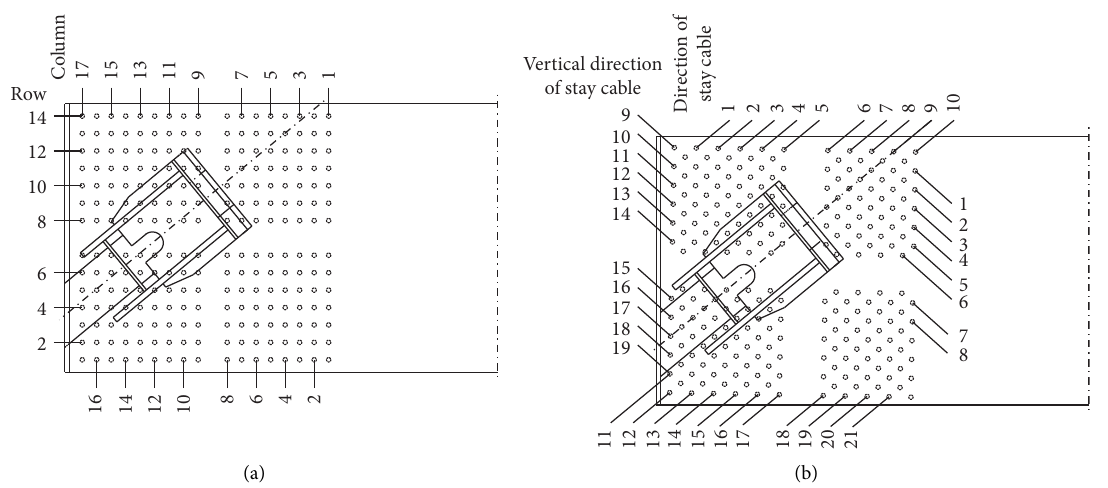
Figure 21: Optimal arrangement for the stud group. (a) Original arrangement. (b) Optimal distribution of the stud group is uneven, and the studs on the stud group on the mid-span side is mainly toward the mid two sides of the stud group (1 st and 17 th columns), near the span, while the shear force direction of the side-span side is mainly toward the side span. The horizontal shear force shear plate (8 th and 9 th columns), and at the connection